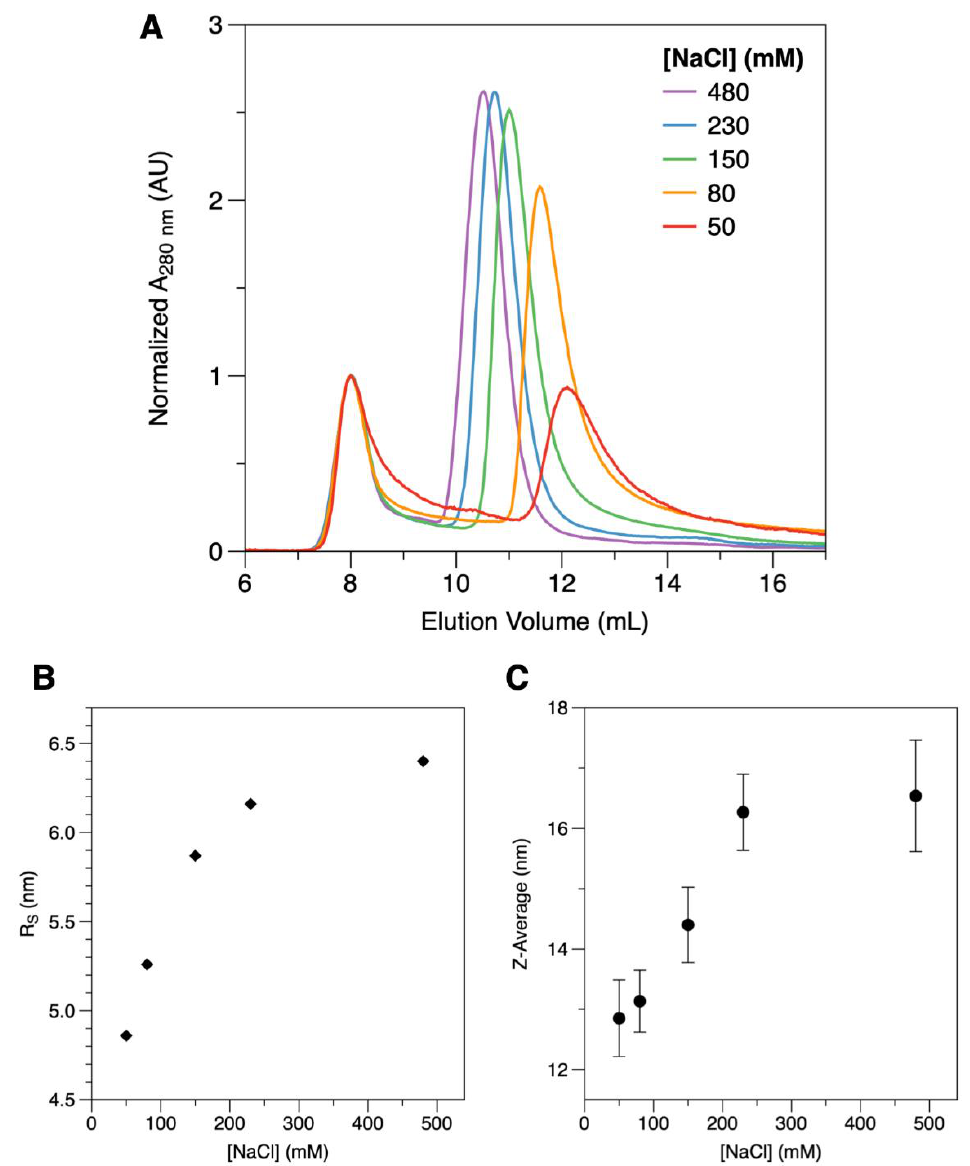
Figure 2. Impact of the ionic strength on the structure of DgrDps WT. ( A ) SEC elution profiles of DgrDps WT in 50 mM MOPS pH 7.0 buffer containing varying concentrations of NaCl, between 480 mM (purple), 230 mM (blue), 150 mM (green), 80 mM (orange) and 50 mM (red), co-eluted with blue dextran for determination of the void volume. ( B ) Ionic strength dependence of the Stokes radius (R S ) estimated by SEC; ( C ) Hydrodynamic diameter (Z-average) variation with buffer salt concentration, as determined by DLS.